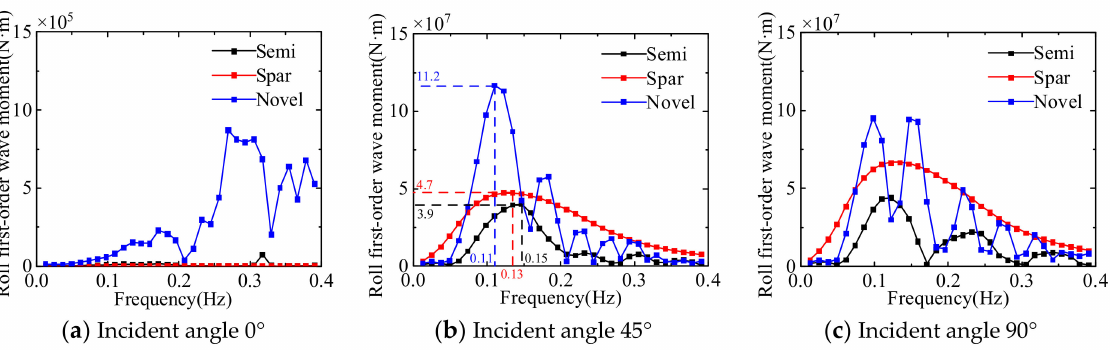
Figure 14. Comparison of the first-order wave moment in the roll direction of three floating platforms.